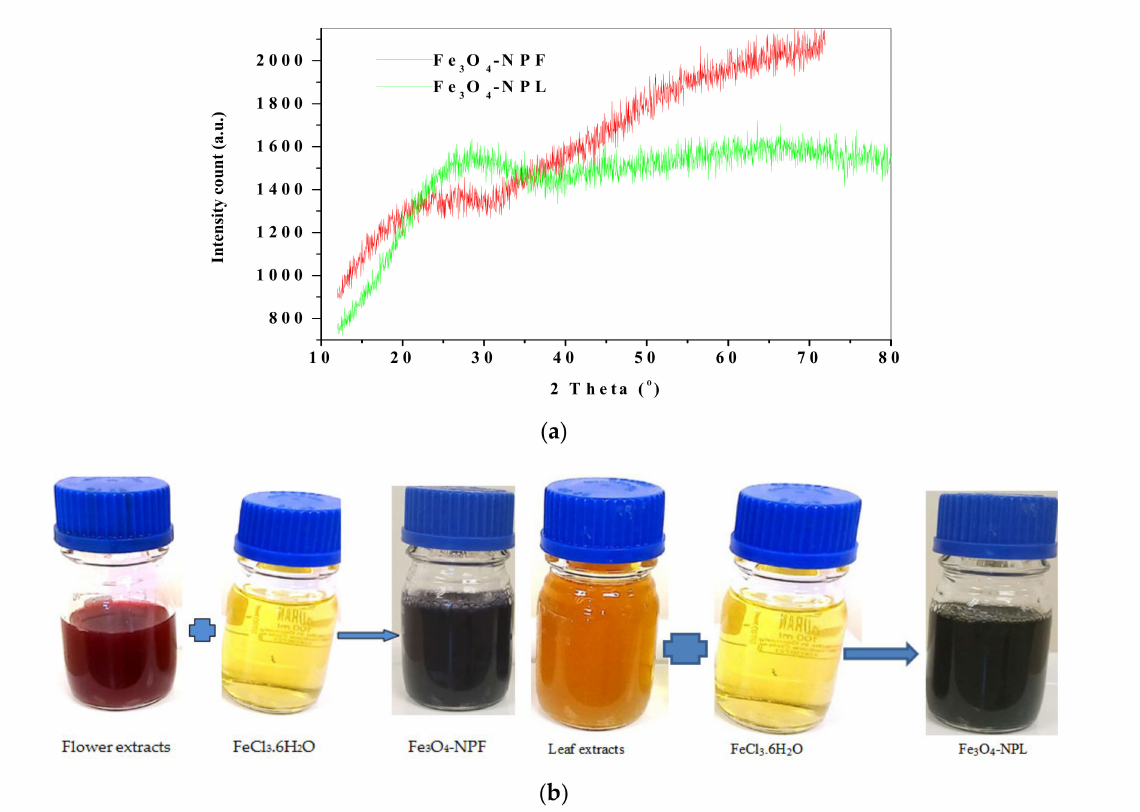
Figure 10. ( a ) X-ray di ff raction pattern of Fe 3 O 4 -NP from C. viminalis leaf and flower extracts, ( b ) colour formation of Fe 3 O 4 -NPF and Fe 3 O 4 -NPL with FeCl 3 . 6H 2 O during